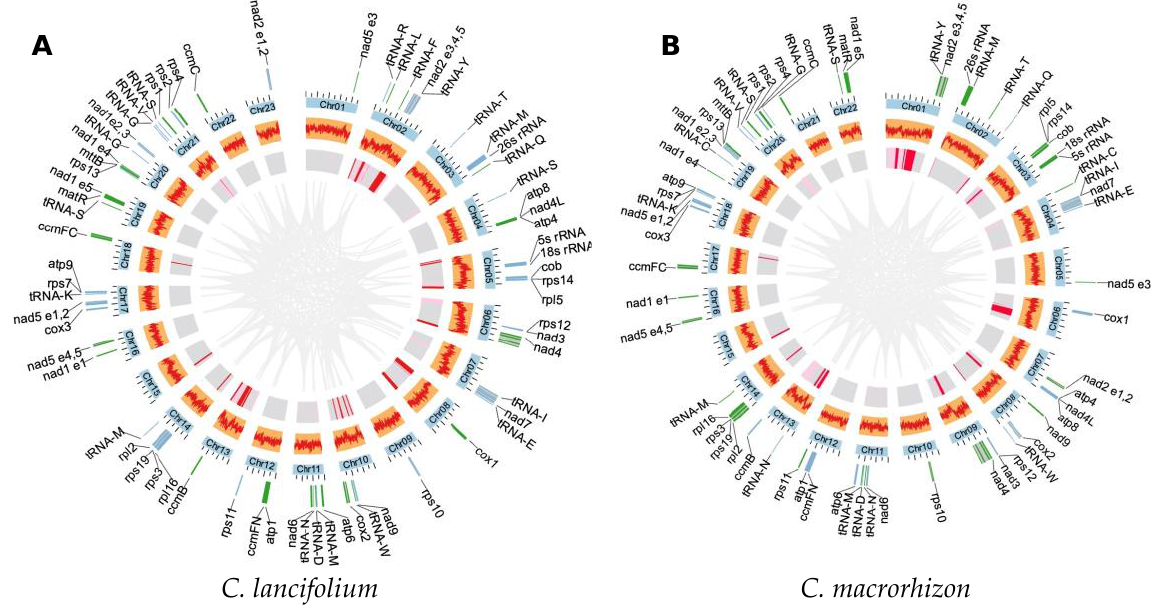
Figure 1. The complete mitogenomes of C. lancifolium and C. macrorhizon . ( A ) The mitogenome structure and features of the leafy C. lancifolium . ( B ) The mitogenome structure and features of the leafless C. macrorhizon. From outermost to innermost, circle I: mitochondrial genes transcribed clockwise and counterclockwise are shown in green and blue, respectively; circle II: mitochondrial chromosomes; circle III: GC content; circle IV: MIPT sequences; circle V: repeats across